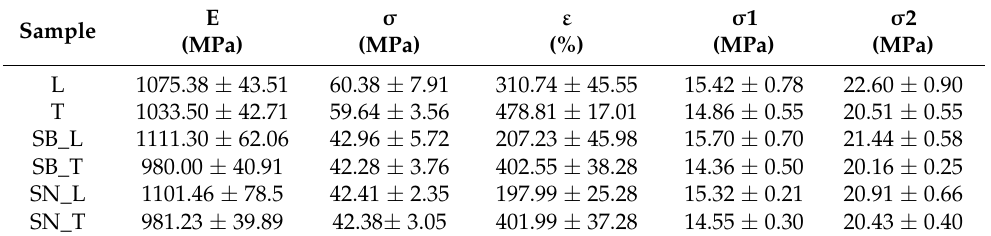
Table 2. E, σ, σ1, σ2 , and ε for the non-aged and aged L and T specimens of ETFE polymer. Table 2. E, σ , σ 1, σ 2, and ε for the non-aged and aged L and T specimens of ETFE polymer.